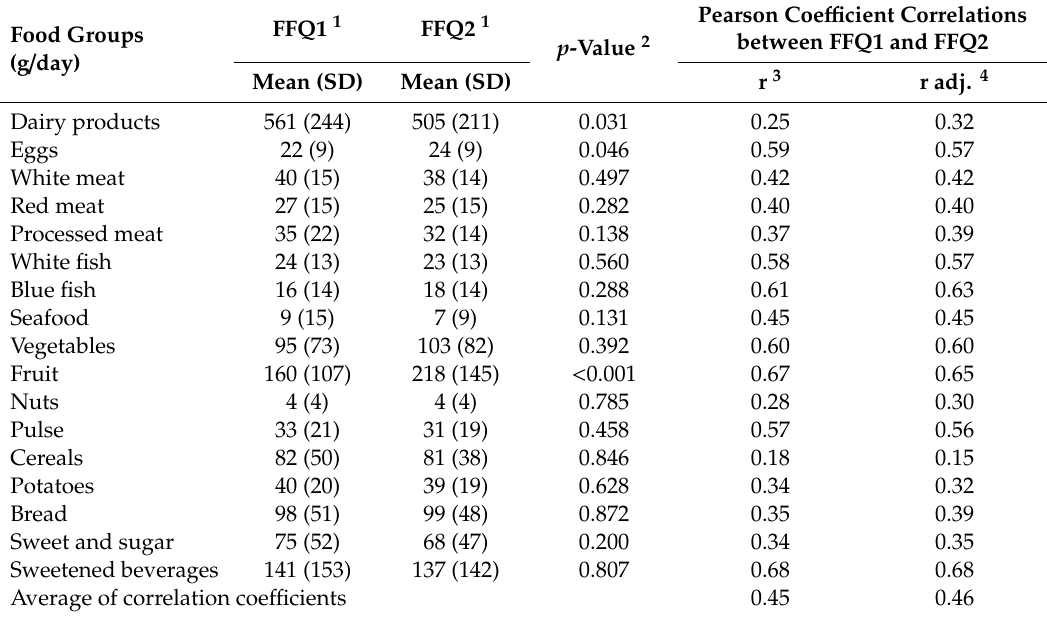
Table 4. Mean daily food group intakes and Pearson correlation coe ffi cients in two FFQs among children aged 7–9 years of the INMA-Valencia study ( n =